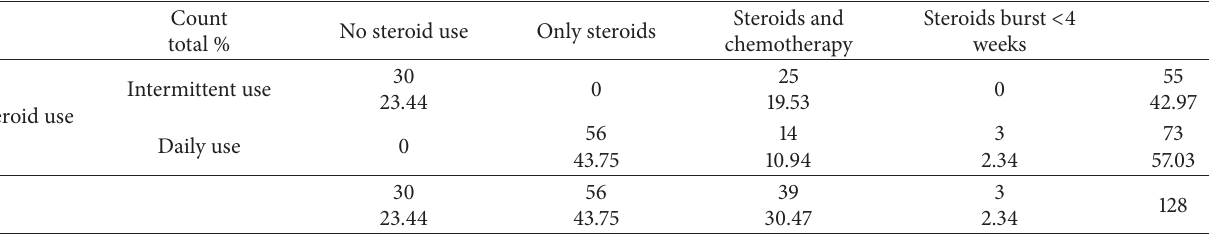
Table 2: Daily corticosteroids use in non-HIV patients with PCP.